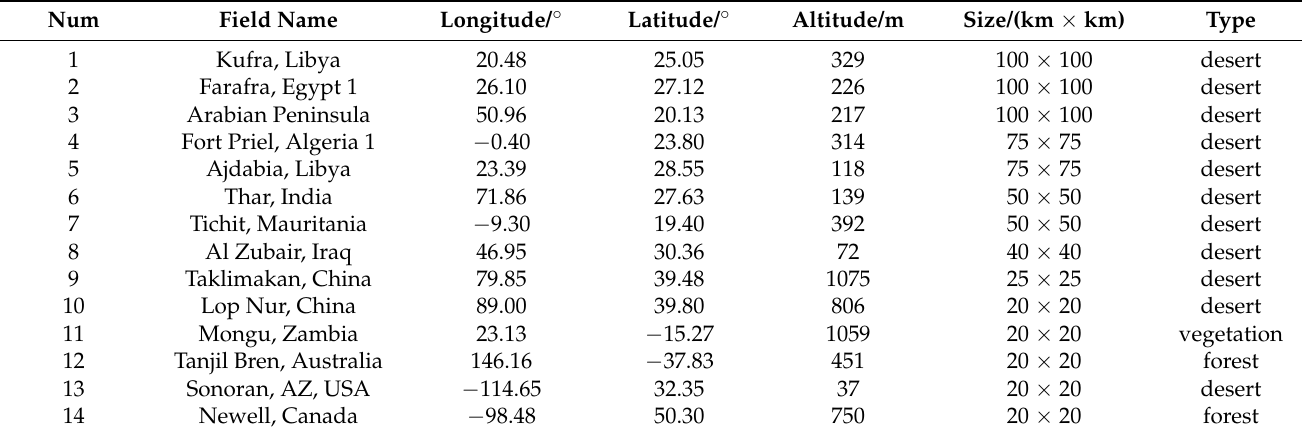
Table 5. GMI radiation calibration field